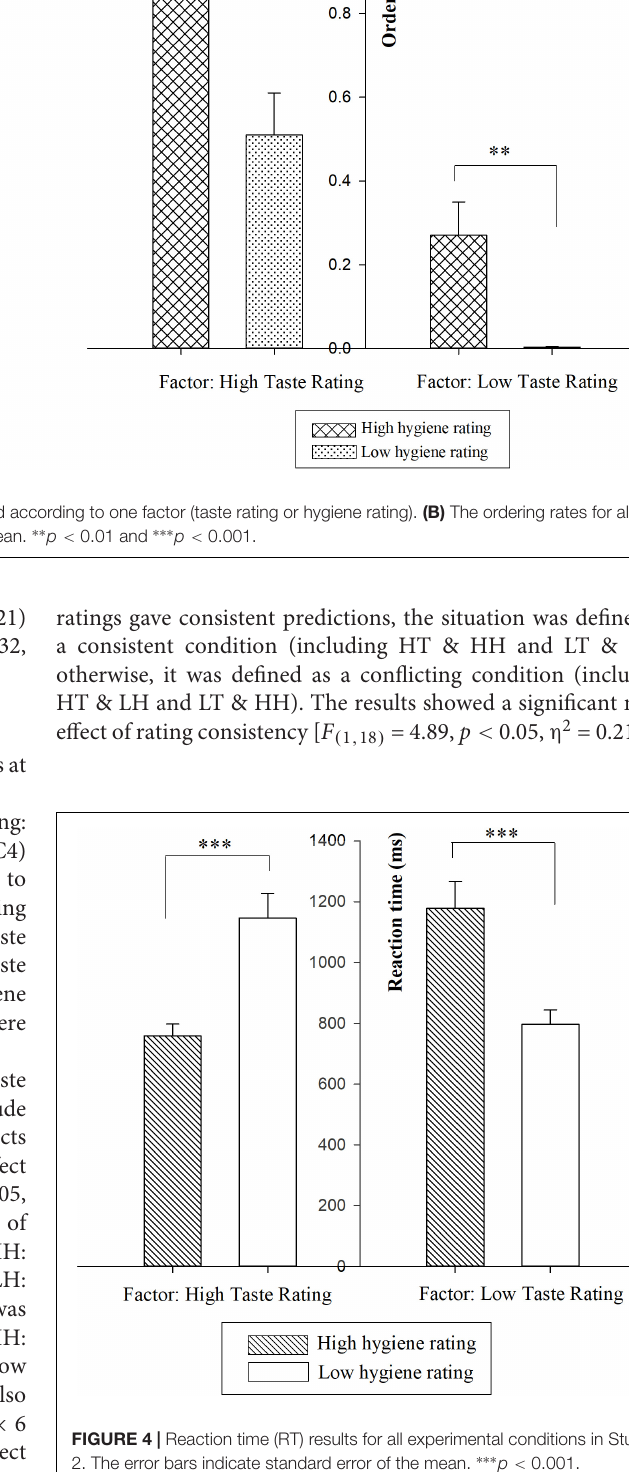
Frontiers in Neuroscience |